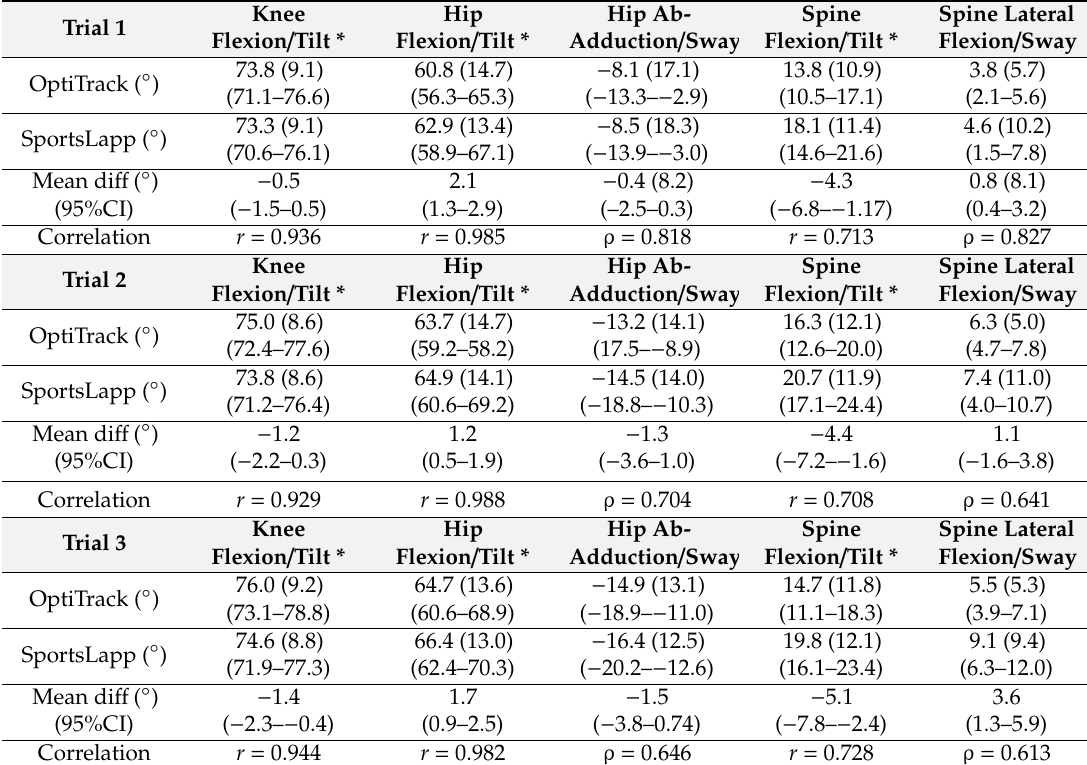
Table 2. Correlations between measures with OptiTrack and SportsLapp motion capture systems for sagittal and frontal plane angles of knee, hip and